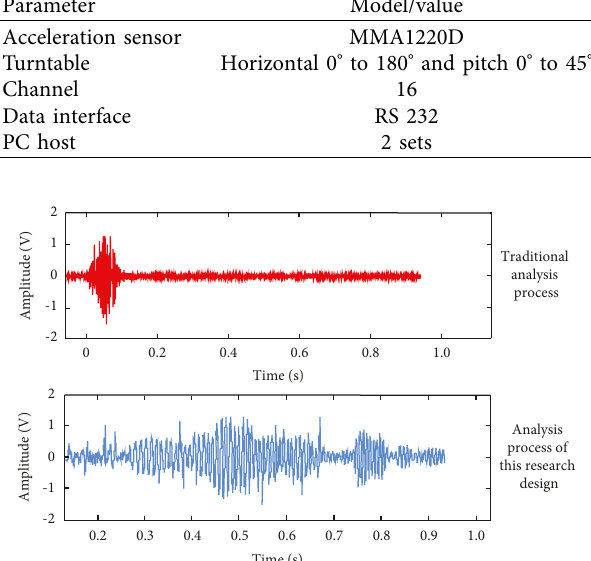
Figure 6: Seismic waveforms obtained by different analysis processes.